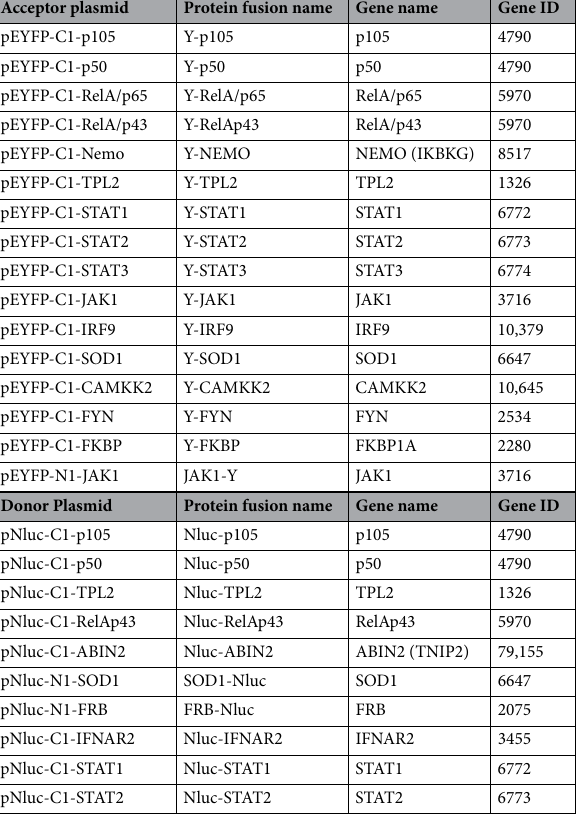
Table 1. Human gene expression